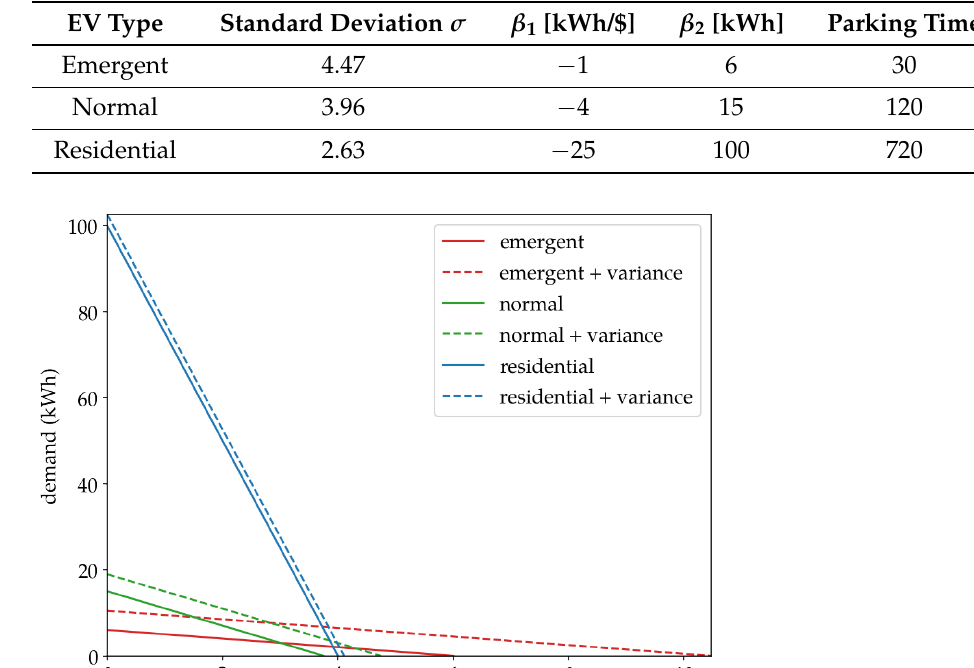
Table 1. Demand–response function parameters and parking time for each EV type.